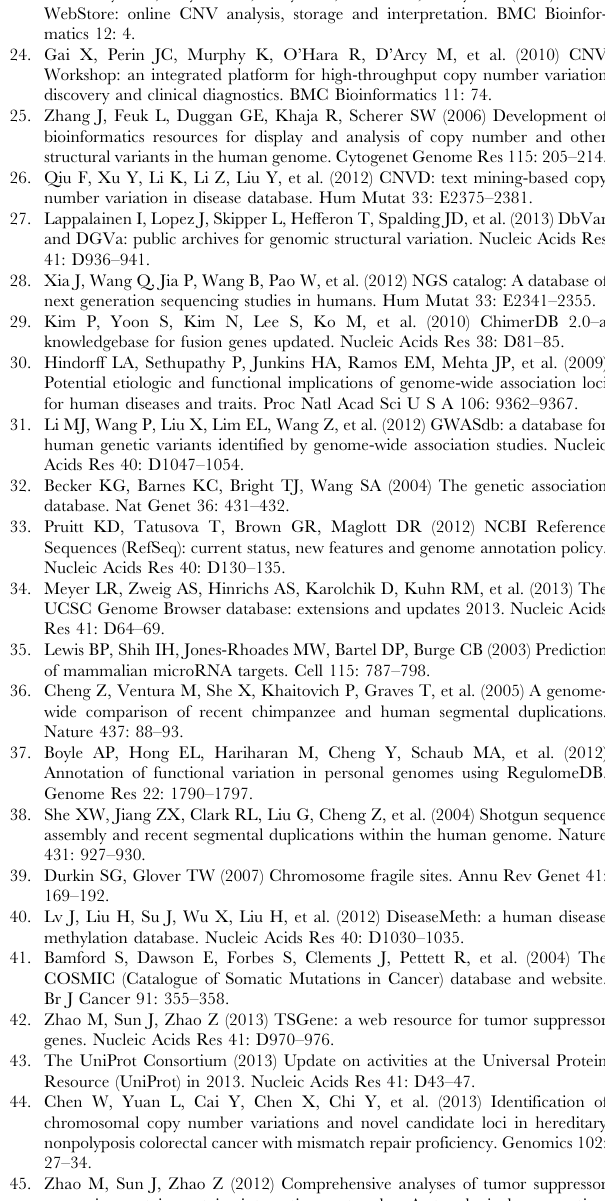
Figure S1 The one-stop model for region-base query in CNVannotator. Figure S2 The job retrieval system in CNVannotator. (A) Finished job access resulting from inputting single or multiple job IDs. (B) Job retrieval results, which include hyperlinks for the downloadable tabular result files.